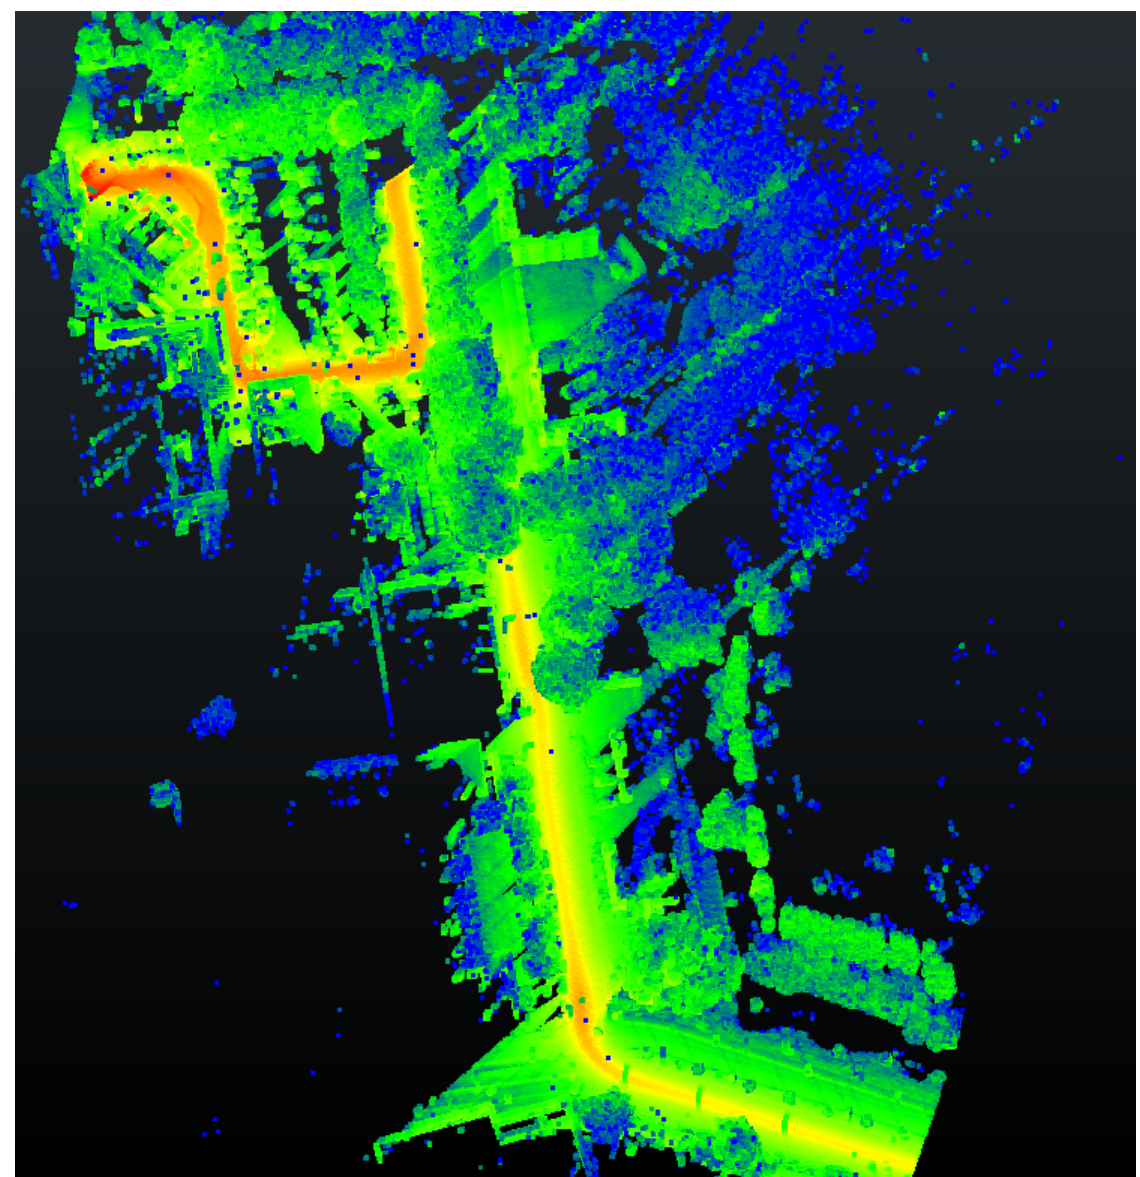
Figure 7: The local point density of the MLS point cloud is illustrated with false color. The warm colors which correspond to high density values also give clue about the driving trajectory of the mobile laser scanning